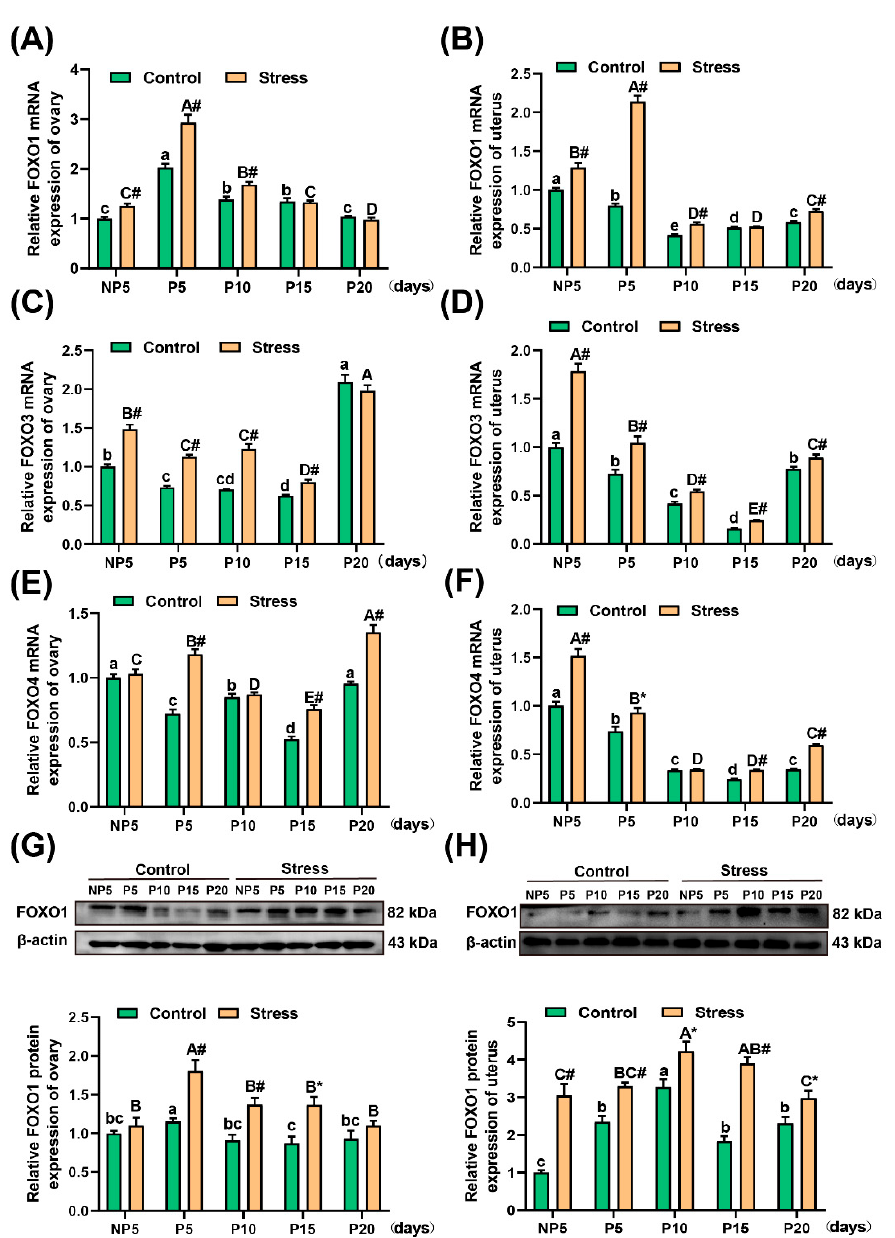
Figure 5. Effect of restraint stress on FOXO mRNA levels and FOXO1 protein in the uterus and ovary of pregnant mice. Restraint stress significantly increased the level of Forkhead transcription factor class O (FOXO) mRNA associated with oxidative stress in the ovary ( A , C , E ) and uterus ( B , D , F ), suggesting that the oxidative stress experienced by the body was excessive. Furthermore, the relative expression of FOXO1 was highest among FOXO, so the protein level of FOXO1 was detected by WB and significantly increased in the ovary ( G ) and uterus ( H ). The data are expressed as the mean ± SEM. Lowercase letters in the column (a, b, c and d) represent the differences between NP5 ( n = 10), P5 ( n = 10), P10 ( n = 10), P15 ( n = 10), and P20 ( n = 10) in the control group ( p < 0.05), and uppercase letters in the column (A, B, C, D and E) represent the differences between NP5 ( n = 10), P5 ( n = 10), P10 ( n = 10), P15 ( n = 10), and P20 ( n = 10) in the stress group ( p < 0.05). The value of NP1 was regard as 1 to be used as the base level of assessment. * p < 0.05 and # p < 0.01 were used to denote the significance of the stress group compared with the corresponding control